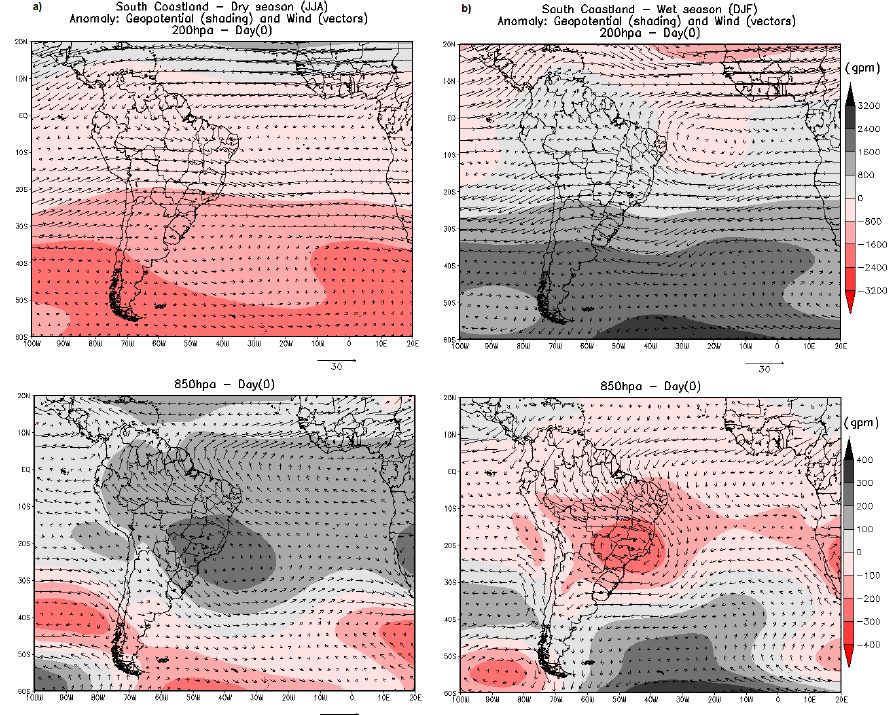
Fig. 4. Geopotential anomaly (shading) and wind anomaly (vectors) at 200hPa and 850hPa for the south coastland: (a) dry season and (b) wet